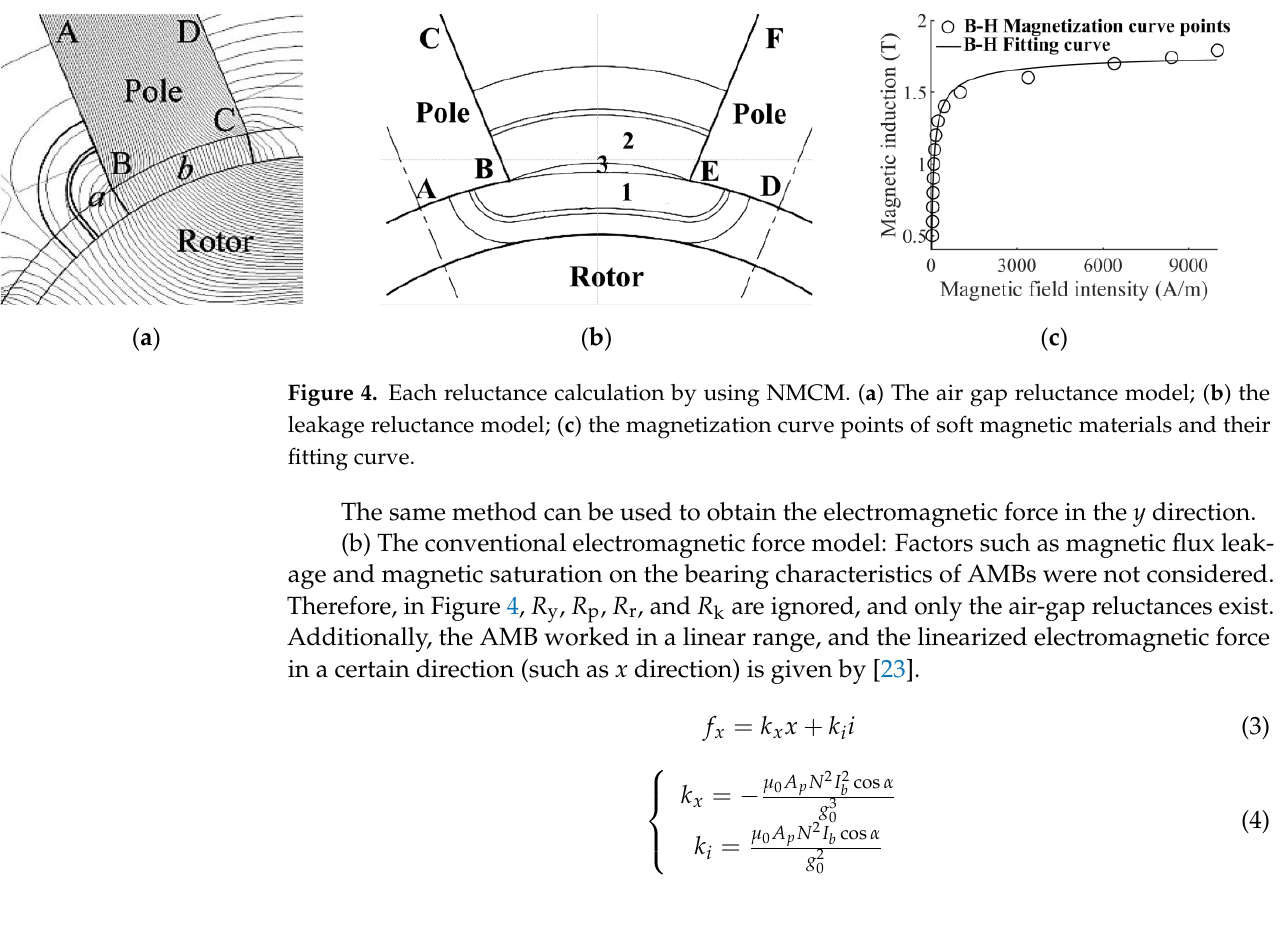
( b ) Figure 5. Bearing capacity curves. ( a ) e = 0.; ( b ) e = 20%. In Figure 5, e is the ratio of radial eccentricity to normal air-gap length. The results of the nonlinear electromagnetic force model and FEM are in good agreement, and these two results are obviously different from those of the linear electromagnetic force model, espe- cially when the control current was large.